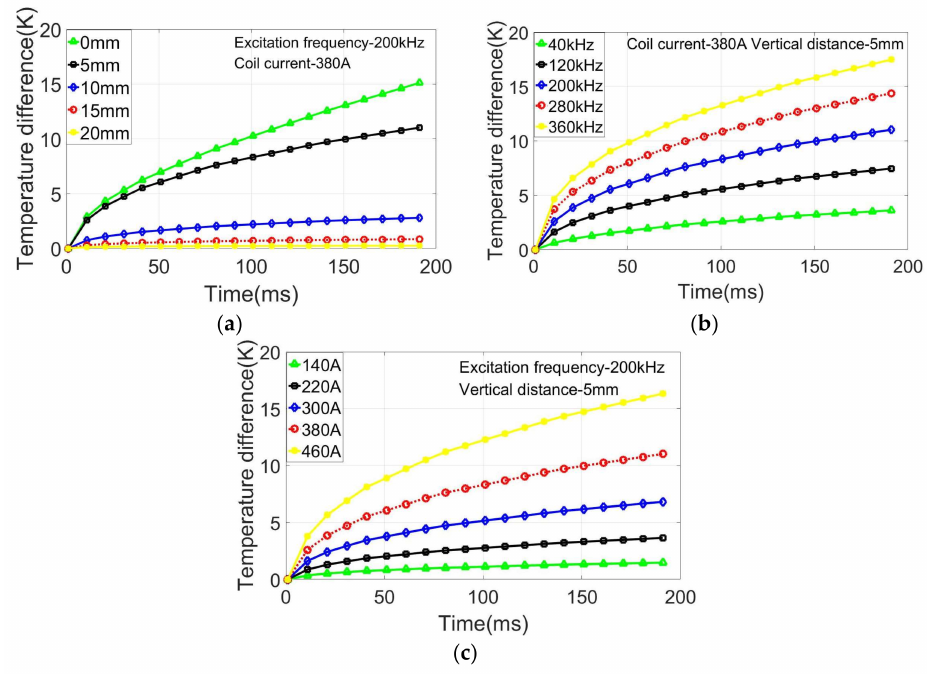
Figure 4. Temperature variation as a function of ( a ) vertical distance, ( b ) excitation frequency, and ( c ) coil